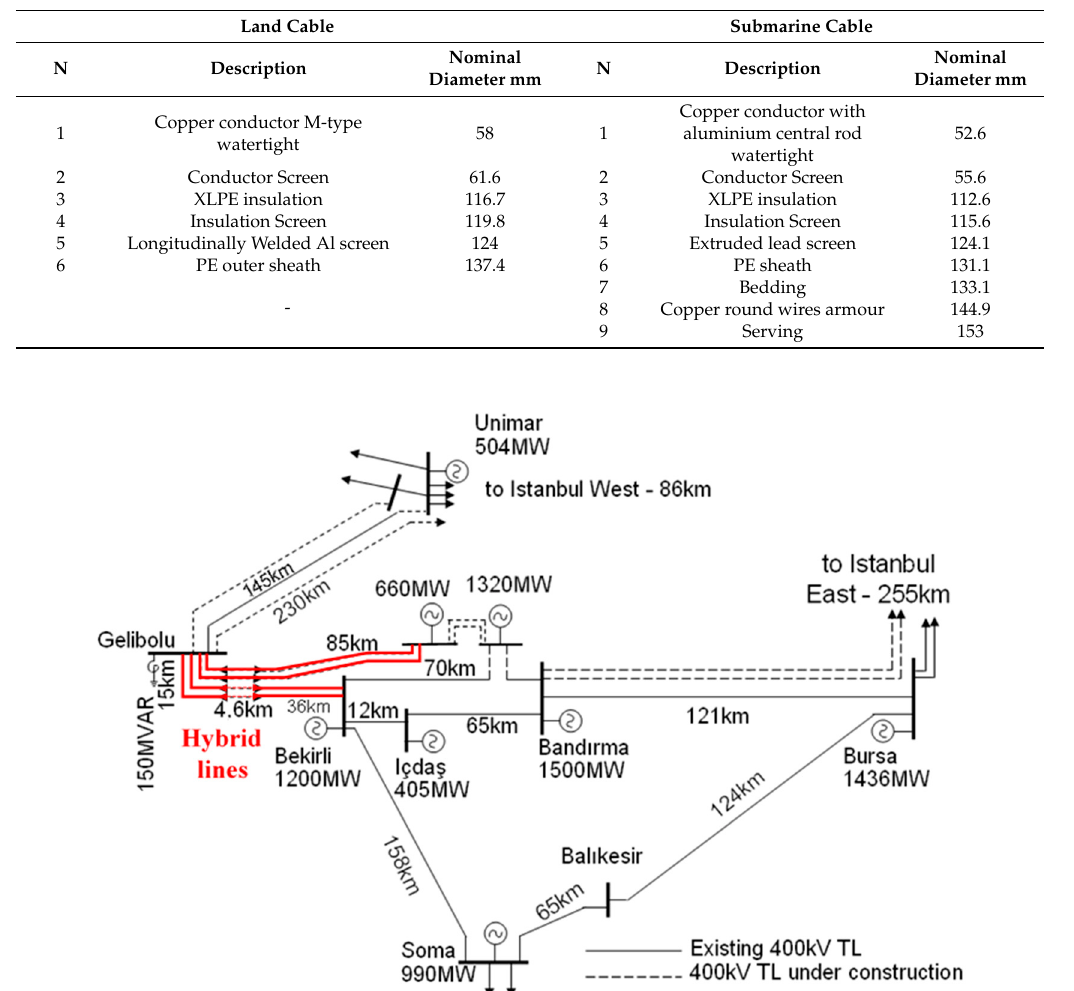
Table 1. Land and submarine cable geometrical characteristics (XLPE: cross-linked polyethylene; PE: polyethylene).